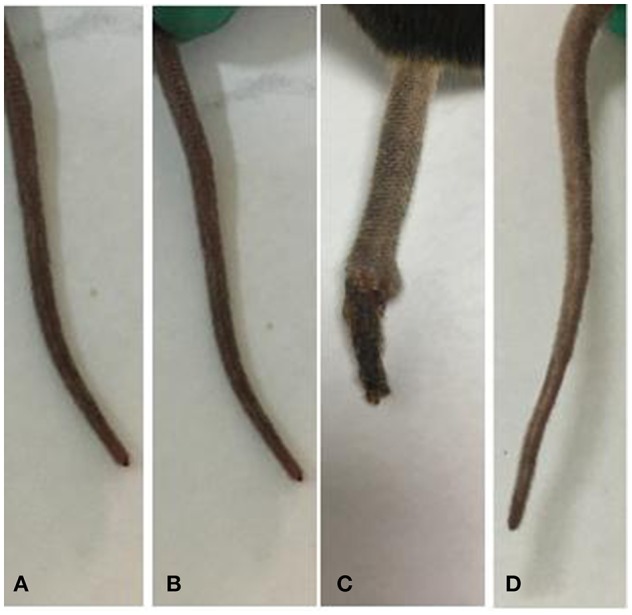
Tail wounds readily healed after SEA treatment. (A) C57BL/6 group; (B) SEA group; (C)
Leprdb/db group; (D)
Leprdb/db + SEA group.